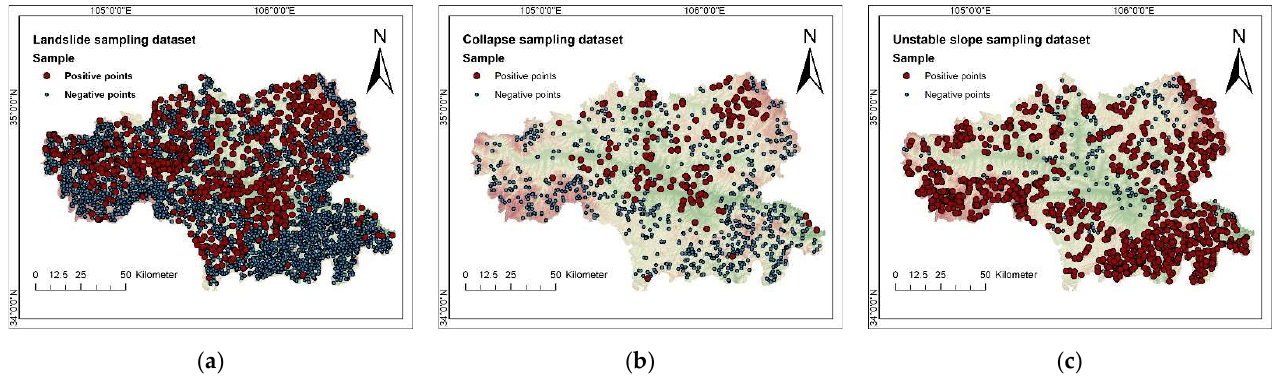
Table 4. Sample number within each sampling dataset.